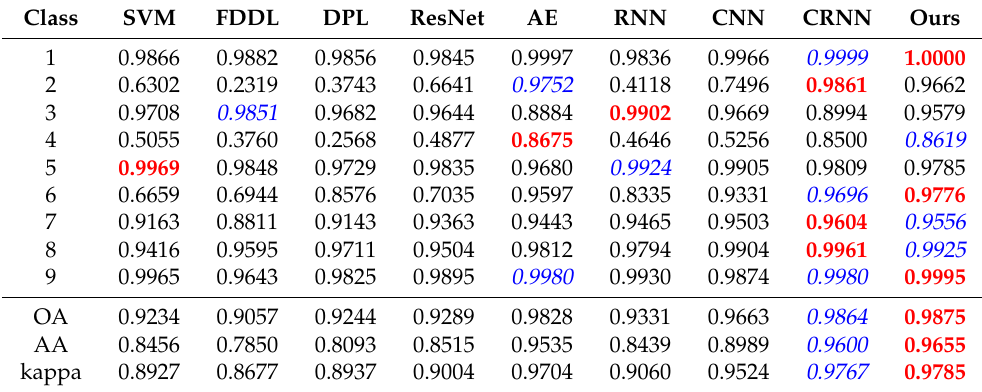
Table 1. Classification Accuracy for Center of Pavia Dataset. The red bold fonts and blue italic fonts indicate the best and the second best